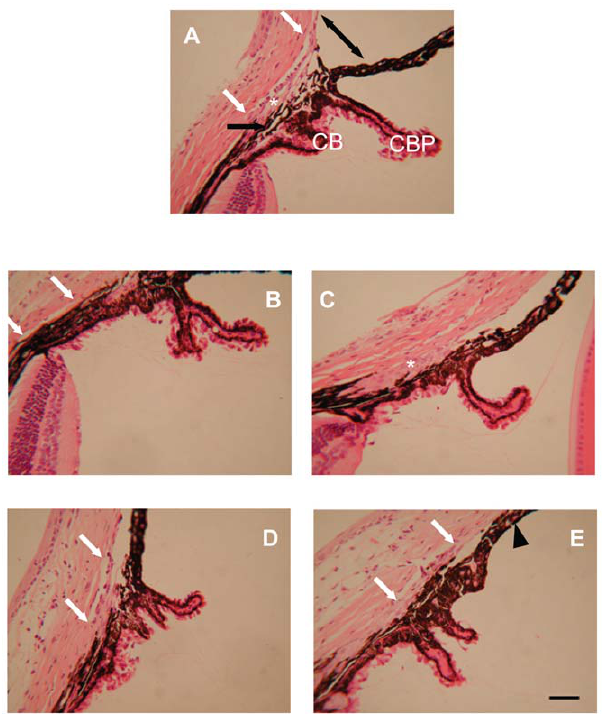
Figure 4. Iridocorneal phenotypic features in Foxf2 W174R mice. ( i ), in wildtype mice Schlemm’s canal extends between the two white arrows. The trabecular meshwork is indicated by an asterisk. The ciliary body (CB) and ciliary body process (CBP) extend into the anterior chamber. The ciliary muscle is indicated by the black arrow. Iris Normal iridocorneal angle ( A ) indicated by double-headed arrow. ( B–E ), phenotype in heterozygous Foxf2 W174R mice. All mice had shortened or absent Schlemm’s canal and a hypoplastic CB or CBP. ( C ), Trabecular meshwork is hypoplastic and the iris is parallel to the cornea (no angle). ( E ), Trabecular meshwork is hypoplastic and iridocorneal adhesion (arrowhead) is present. Scale bar =50 m m.